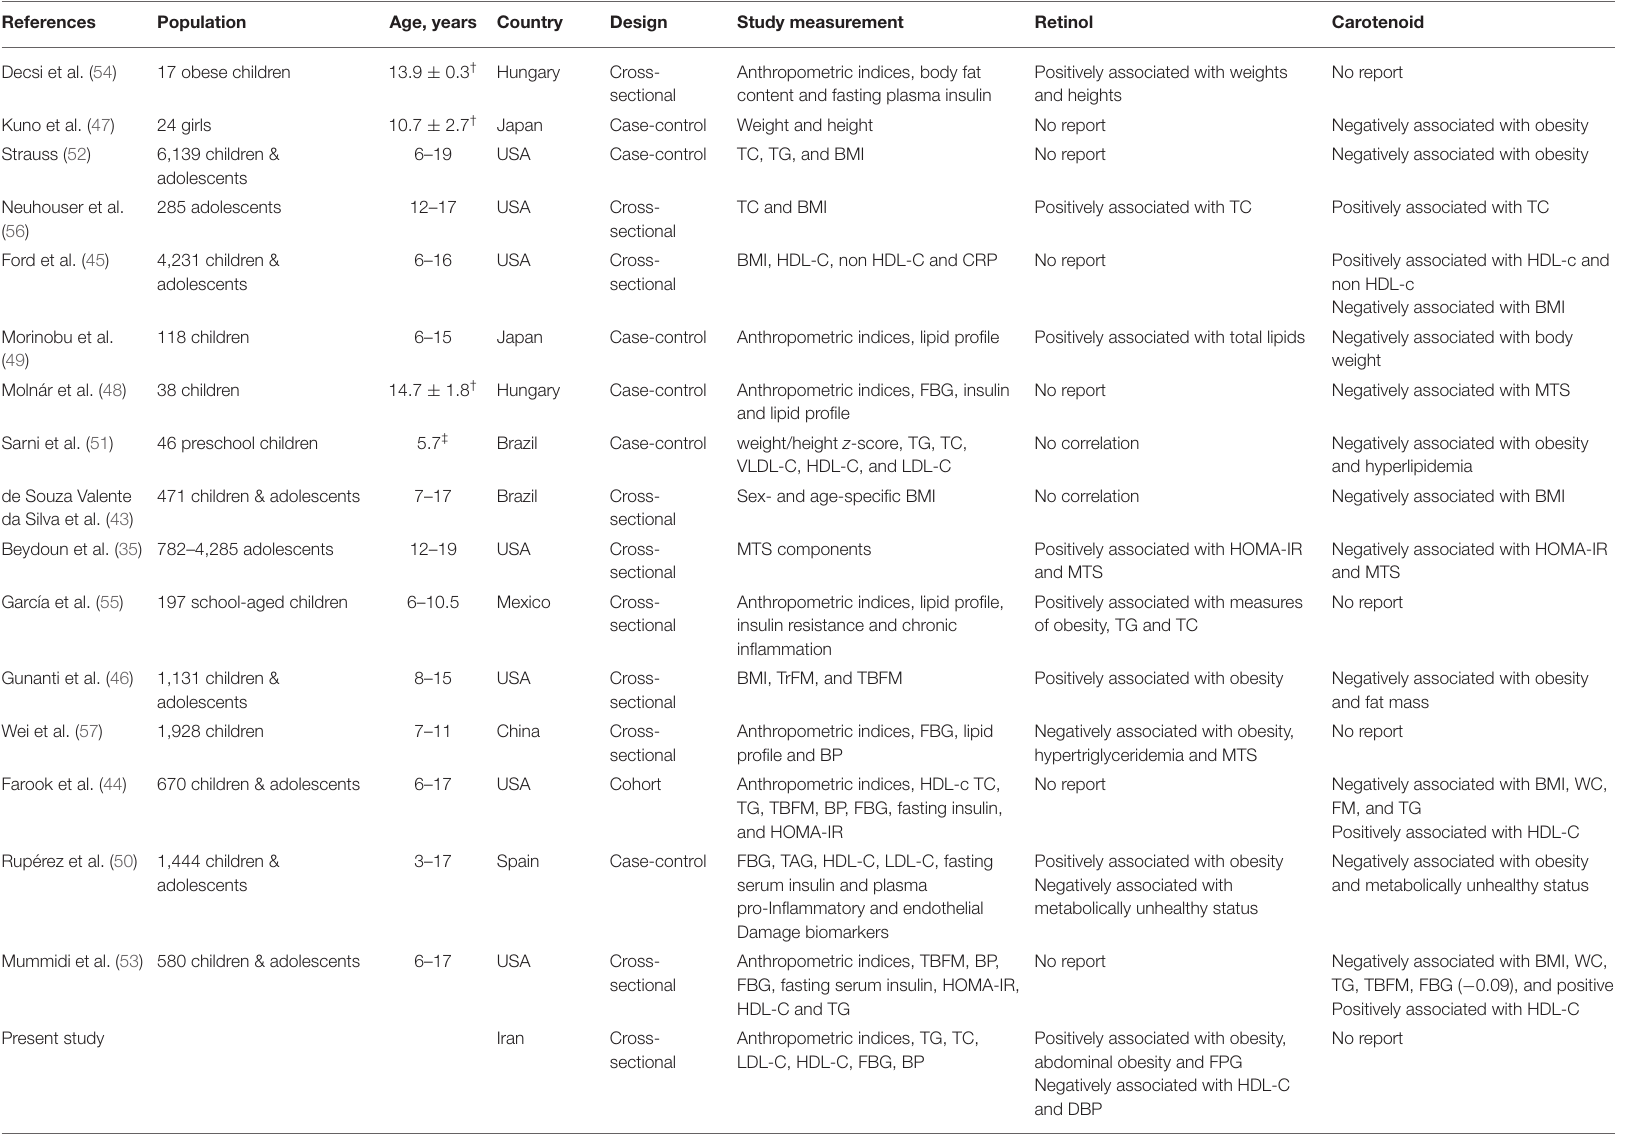
TABLE 6 | Studies that evaluated associations of circulating retinol and carotenoid concentering with obesity and metabolic syndrome components in children and adolescents aged 7–18